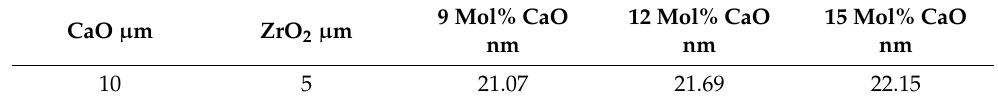
Table 2. XRD grain size measurements in nanometers after 80 h milling.